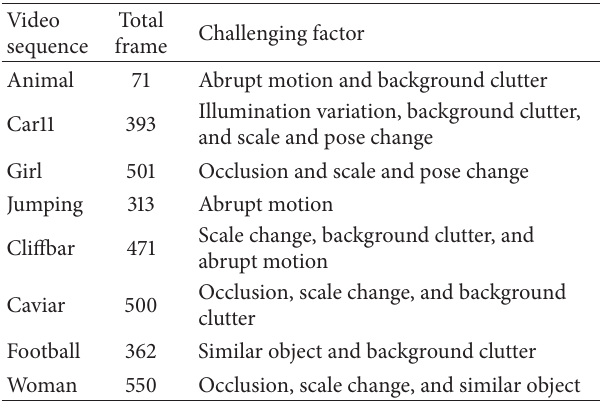
Table 1: All the tested image